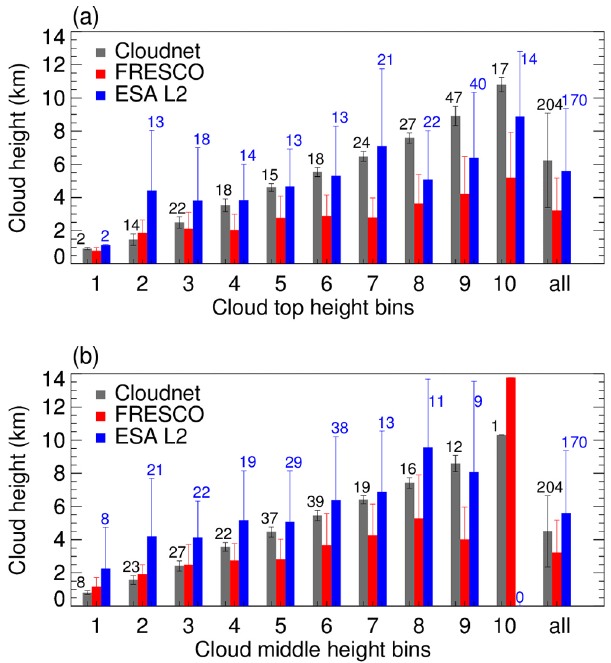
Figure 12. (a) Bar plot of Cloudnet cloud top height, FRESCO cloud height and ESA L2 cloud top height in 1km bins of Cloudnet cloud top height, for multilayer clouds. The height ranges of bins 1– 10 are 0–1, 1–2, 2–3, 3–4, 4–5, 5–6, 6–7, 7–8, 8–10, and > 10km. The bin “all” is the mean of bins 1–10. The number above the bar indicates the number of cases; the number of cases for FRESCO is the same as for Cloudnet. The error bar indicates the standard devi- ation of the data. (b) Same as (a) but for the Cloudnet cloud middle height